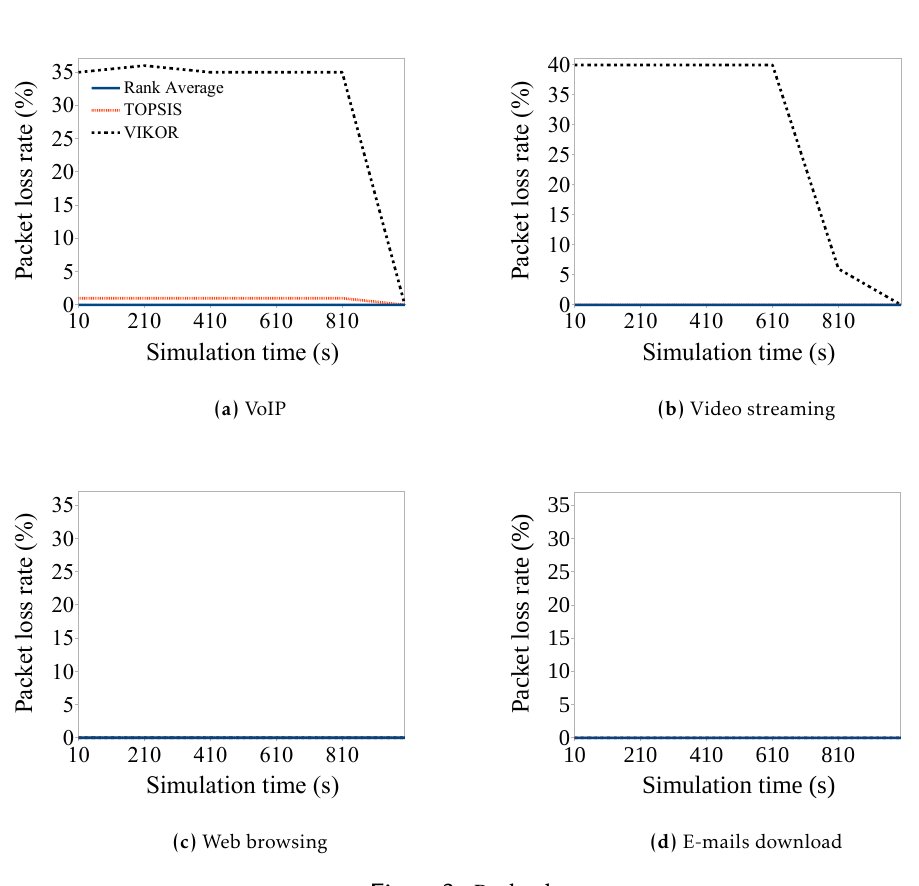
Figure 3. Packet loss